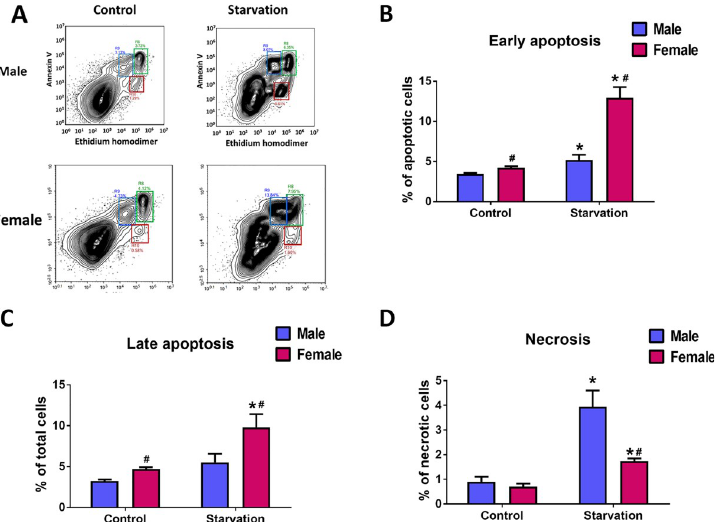
Fig 6. Sex-specific profile of apoptotic and necrotic cell death in HPAEC. Stress in human endothelial cells obtained from age and race matched male and female donors was induced by culturing HPAEC in serum-free media for 48h. A — representative plots showing populations of Annexin V and EthD-1 positive cells in Control and starved male and female HPAEC. B-D– quantitative analysis of early apoptosis, late apoptosis, and necrosis in male and female HPAEC. Values are means ± SEM. N = 6 for each sex. � p < 0.05 versus same-sex Control cells; # p < 0.05 versus male HPAEC. Statistical analysis was performed using unpaired t-test.